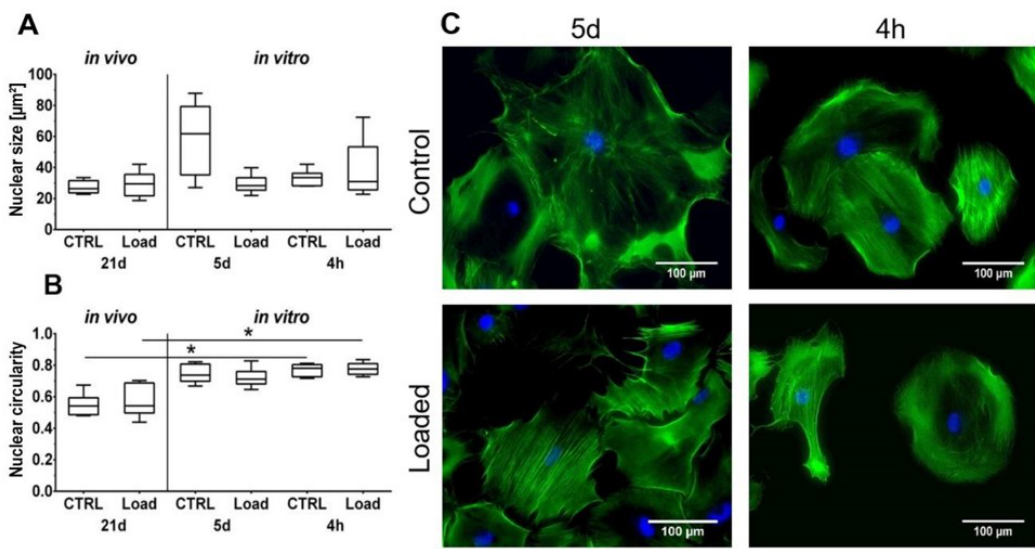
Figure 2. Cell morphology is partially influenced by mechanical loading. ( A ) The nuclear size is not significantly affected. ( B ) Cell nuclei in vitro were significantly rounder compared to in vivo (* p < 0.05, n = 6). ( C ) Phalloidin/ 4 ′ ,6-Diamidin-2-phenylindol (DAPI) staining of loaded murine tenocytes in vitro. Scale bar: 100 µm.